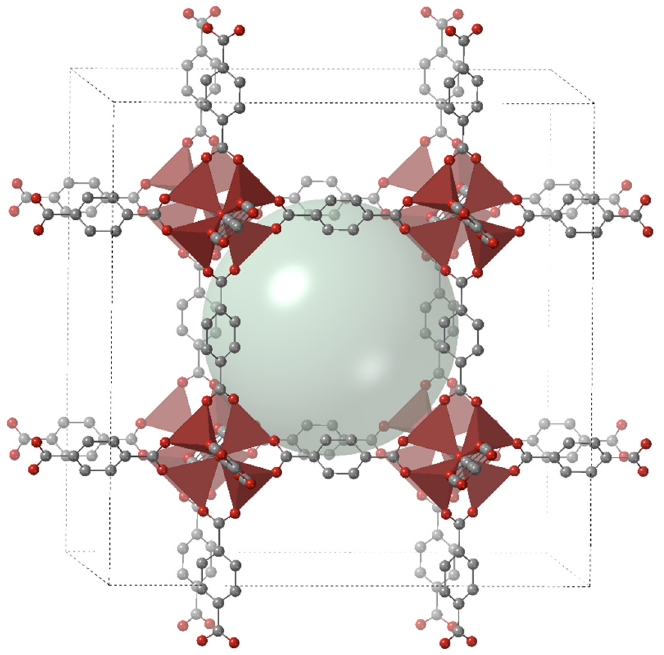
Figure 1. A view of MOF-5 along the z -axis, where the central large sphere represents the cavity size in MOF-5.